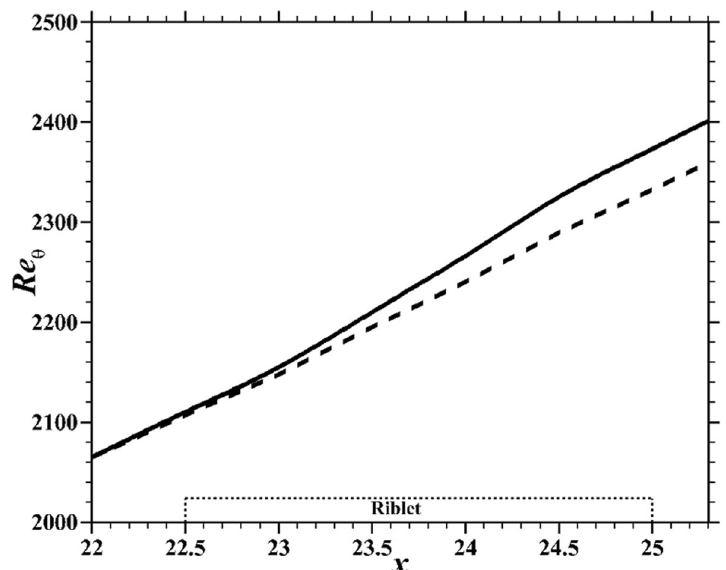
Fig. 5 Spatial development of the boundary-layer momentum Reynolds number Re θ (The solid and dashed lines indicate the riblets case and smooth case, respectively)